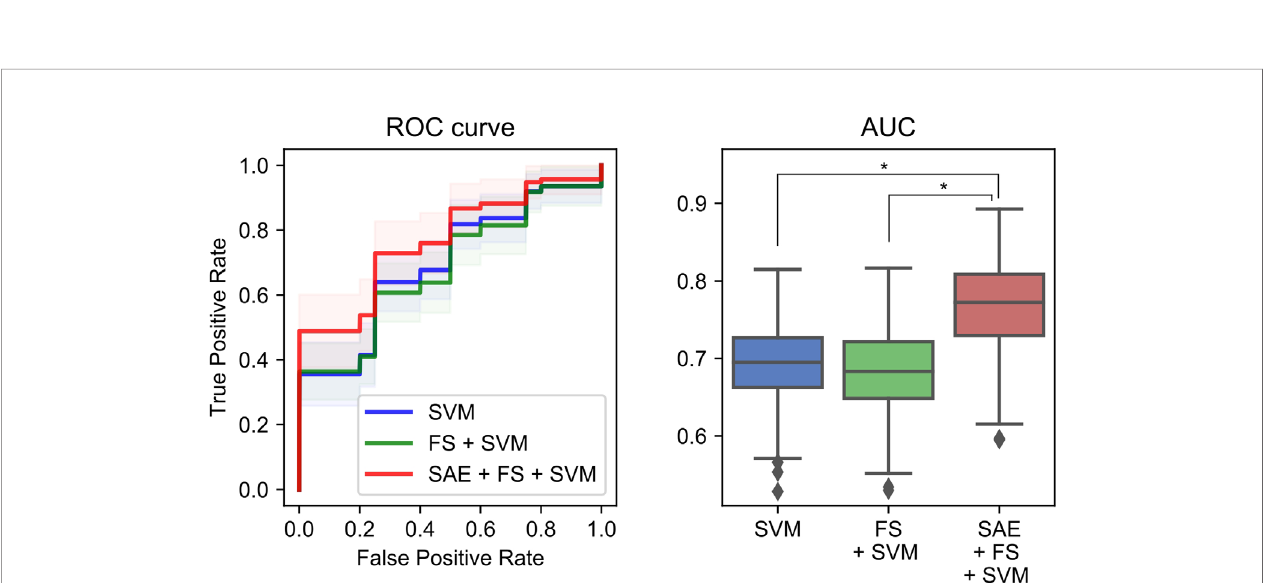
FIGURE 6 | Performance of a combination of the complexity characteristics and machine learning (ML) methods for the diagnosis of Alzheimer ’ s disease (AD). The area under the receiver operating characteristic curve (AUC) was 0.70 ± 0.05 for the simple support vector machine (SVM), 0.68 ± 0.05 for the feature selection (FS) + SVM, and 0.77 ± 0.06 for the sparse autoencoder (SAE) + FS + SVM. * p <